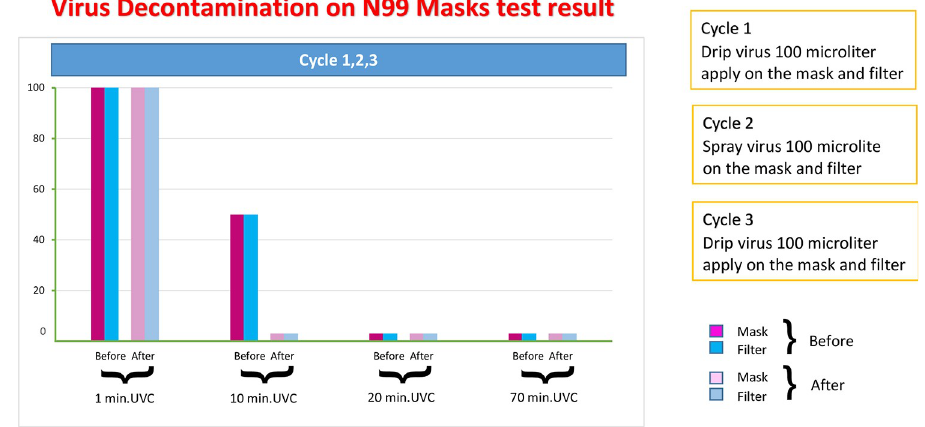
Fig 11. Effect of alcohol and UVC decontamination on silicone masks at different sites and times.